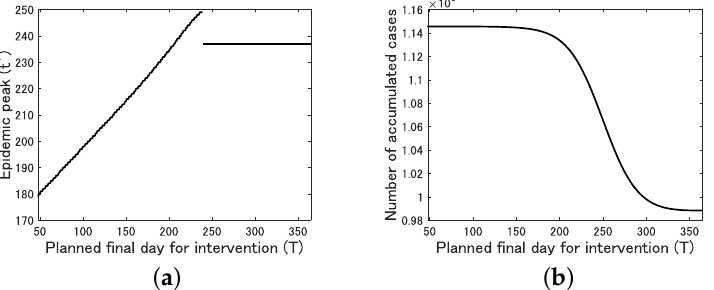
Figure 5. The relation between the planned final day for intervention T and ( a ) the epidemic peak t ∗ ; ( b ) the number of accumulated cases at time t = 365: pR ( 365 ) × 1.26 × 10 8